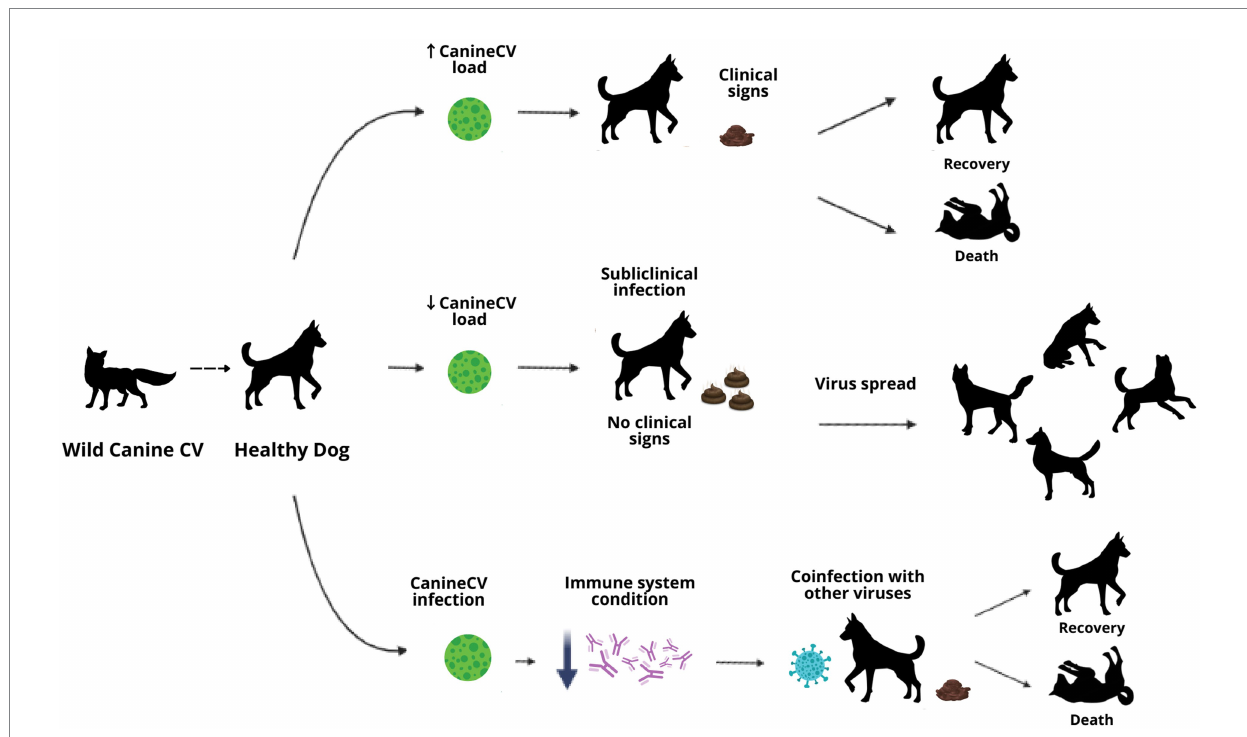
FIGURE 4 Diagram of possible disease routes in CanineCV infection in domestic